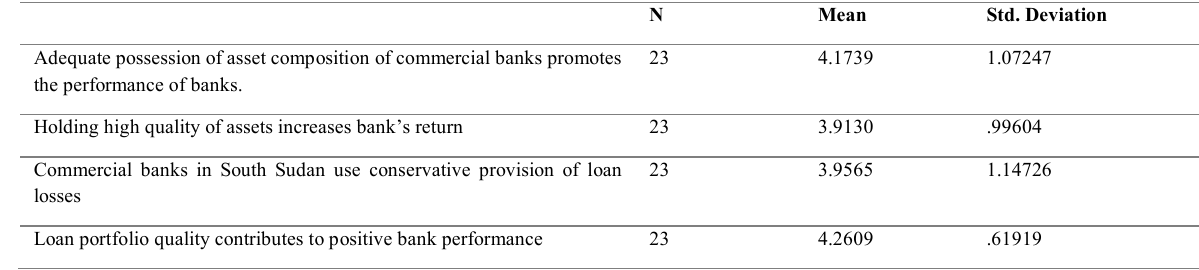
Table 2: Asset quality and financial performance